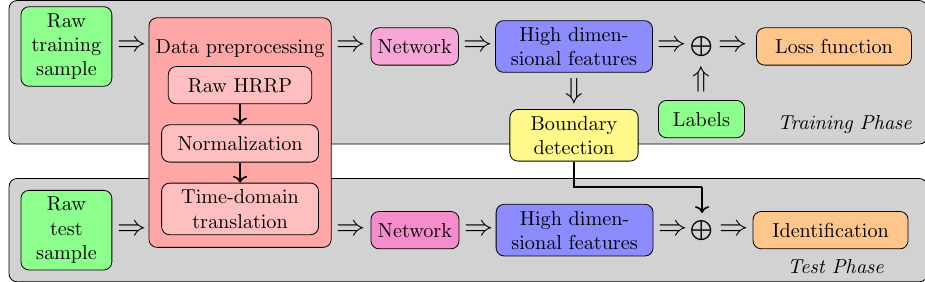
Figure 2. The flow diagram of the proposed method for HRRP